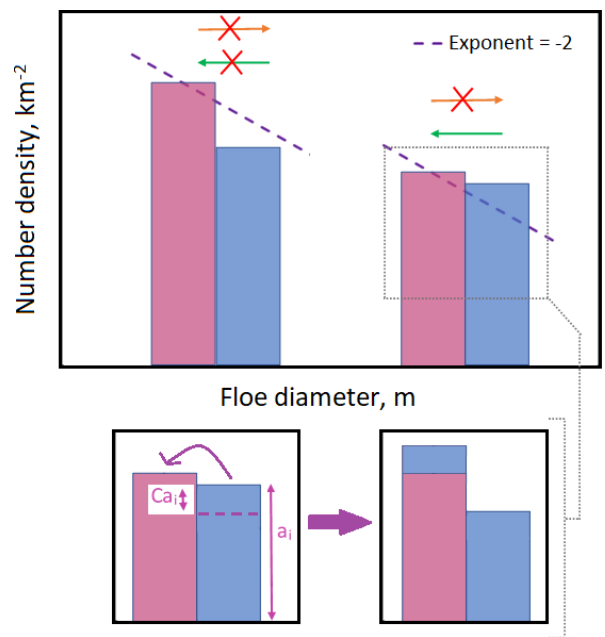
Figure 1. Diagram of the quasi-restoring brittle fracture scheme in- troduced to the prognostic FSD model. The upper section of the plot shows two adjacent pairs of floe size categories, where blue high- lights the larger category and red the smaller category. The brittle fracture scheme only transfers sea ice area fraction from a larger category to the adjacent smaller category and only where the num- ber density gradient between adjacent categories in log-log space is larger (more positive) than − 2. A slope with this gradient is shown by the purple dashed line. The lower section of the plot shows how the scheme can modify the FSD. The sea ice area fraction trans- ferred from the larger to the smaller floe size category is C bf a i , where a i is the total sea ice area fraction in the larger category and C bf is the restoring